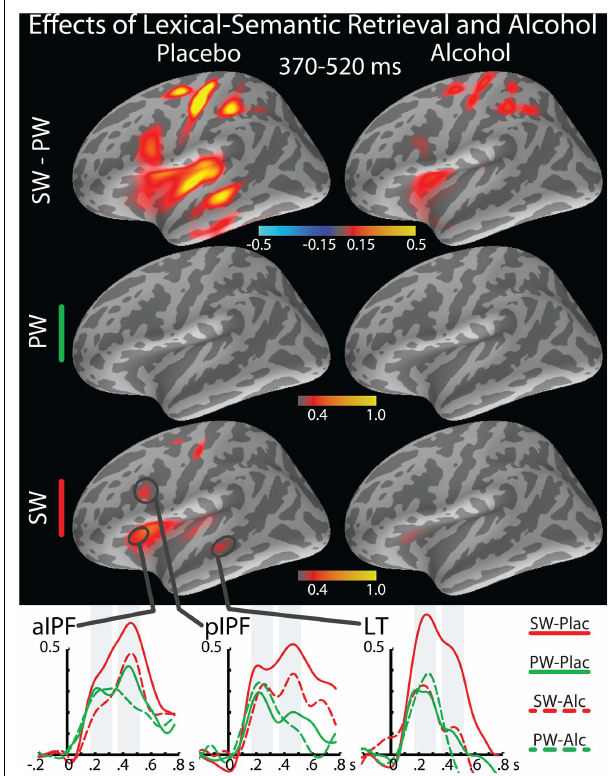
FIGURE 3 | Effects of lexical-semantic retrieval on group average maps of baseline-corrected event-related theta source power estimates in the 370–520ms time-window in the left hemisphere under placebo (left column) and alcohol (right column). Maps in the top row are based on the subtraction of the meaningless PW from real words (SW).The overall averaged estimates to SW and PW are shown below the subtracted estimates. Group average timecourses of the theta estimates to SW and PW under both beverage conditions are shown at the bottom of the figure, along with the time-windows included in the statistical analysis indicated with shaded